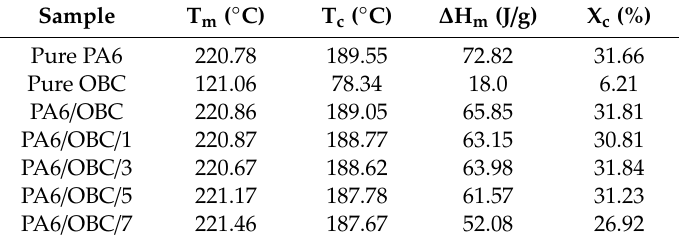
Figure 8. The differential scanning calorimetry (DSC) plots of ( a ) the cooling curves and ( b ) the second heating curves of pure PA6, pure OBC, and the PA6 / OBC and PA6 / OBC / POE-g-MAH blends at various POE-g-MAH contents. Table 3. The DSC results of pure PA6, pure OBC, and the PA6 / OBC and PA6 / OBC / POE-g-MAH blends at various POE-g-MAH contents.